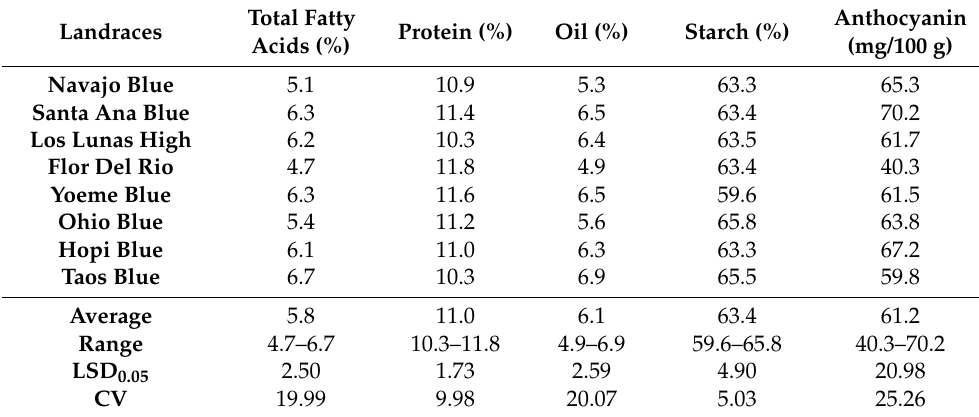
Table 4. Descriptive statistics of kernel biochemical traits evaluated across Los Lunas and Alcalde locations in New Mexico in